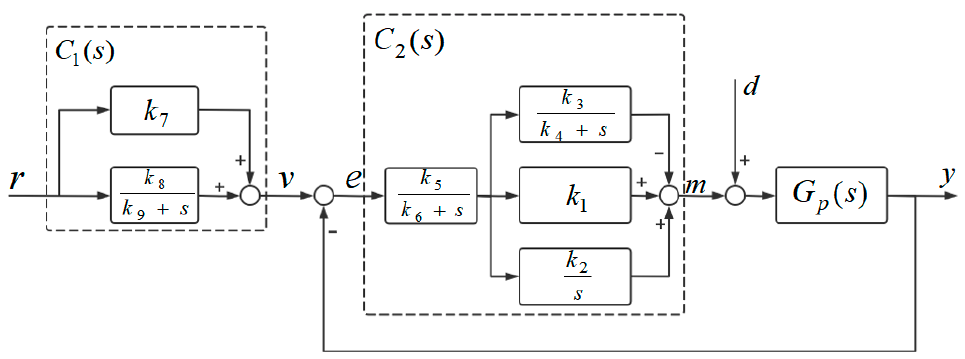
Figure 5. 2DOF IMC-PID control system F 1